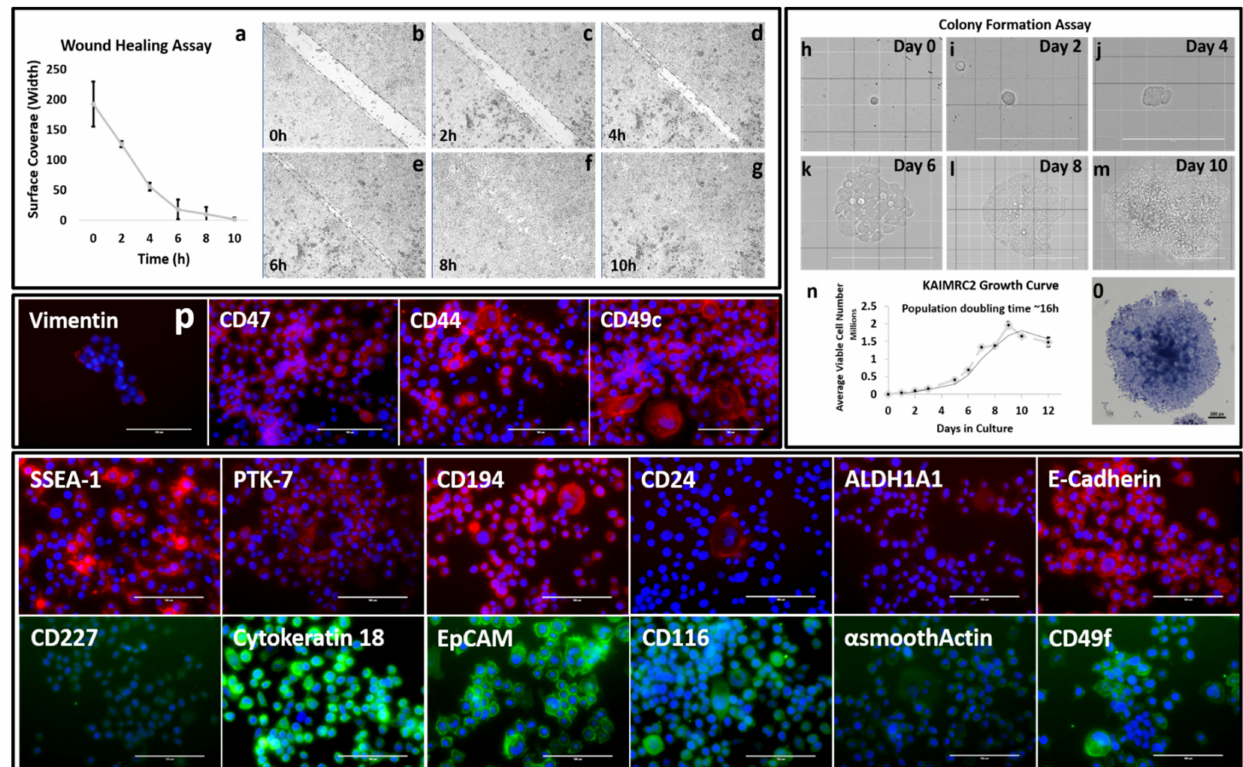
Figure 2. Growth characterization of the KAIMRC2 Cell line. ( a – g ) Wound healing assay of the KAIMRC2 cell line. Live-cell time-lapse images of the wound healing assay were acquired. A confluent layer of the cells was scratched (the area between the two parallel dotted lines), and transmitted light time-lapse imaging was performed for 24 h. Images show cells after 0 h, 2 h, 4 h, 6 h, 8 h, and 10 h. Scale bar = 200 µ m. ( h – m ) Colony formation assay of KAIMRC2 Cell Line. Formation of colonies was visualized microscopically, and transmitted light images were acquired three times a week. Scale bar = 200 µ m except m = 400 µ m. ( o ) Colonies were stained with Hematoxylin and Eosin on day 10, and images were acquired using Molecular Devices EVOS FL Auto system. Scale bar = 200 µ m ( n ) The average growth curves of the cell line are shown. Cells were counted in triplicate for 24 days. The doubling time of KAIMRC2 cell line was approximately 16 h. ( p ) Immunocytochemistry images of a panel of markers to perform a comprehensive proofing of the KAIMRC2 cell line. Scale bars = 100 µ